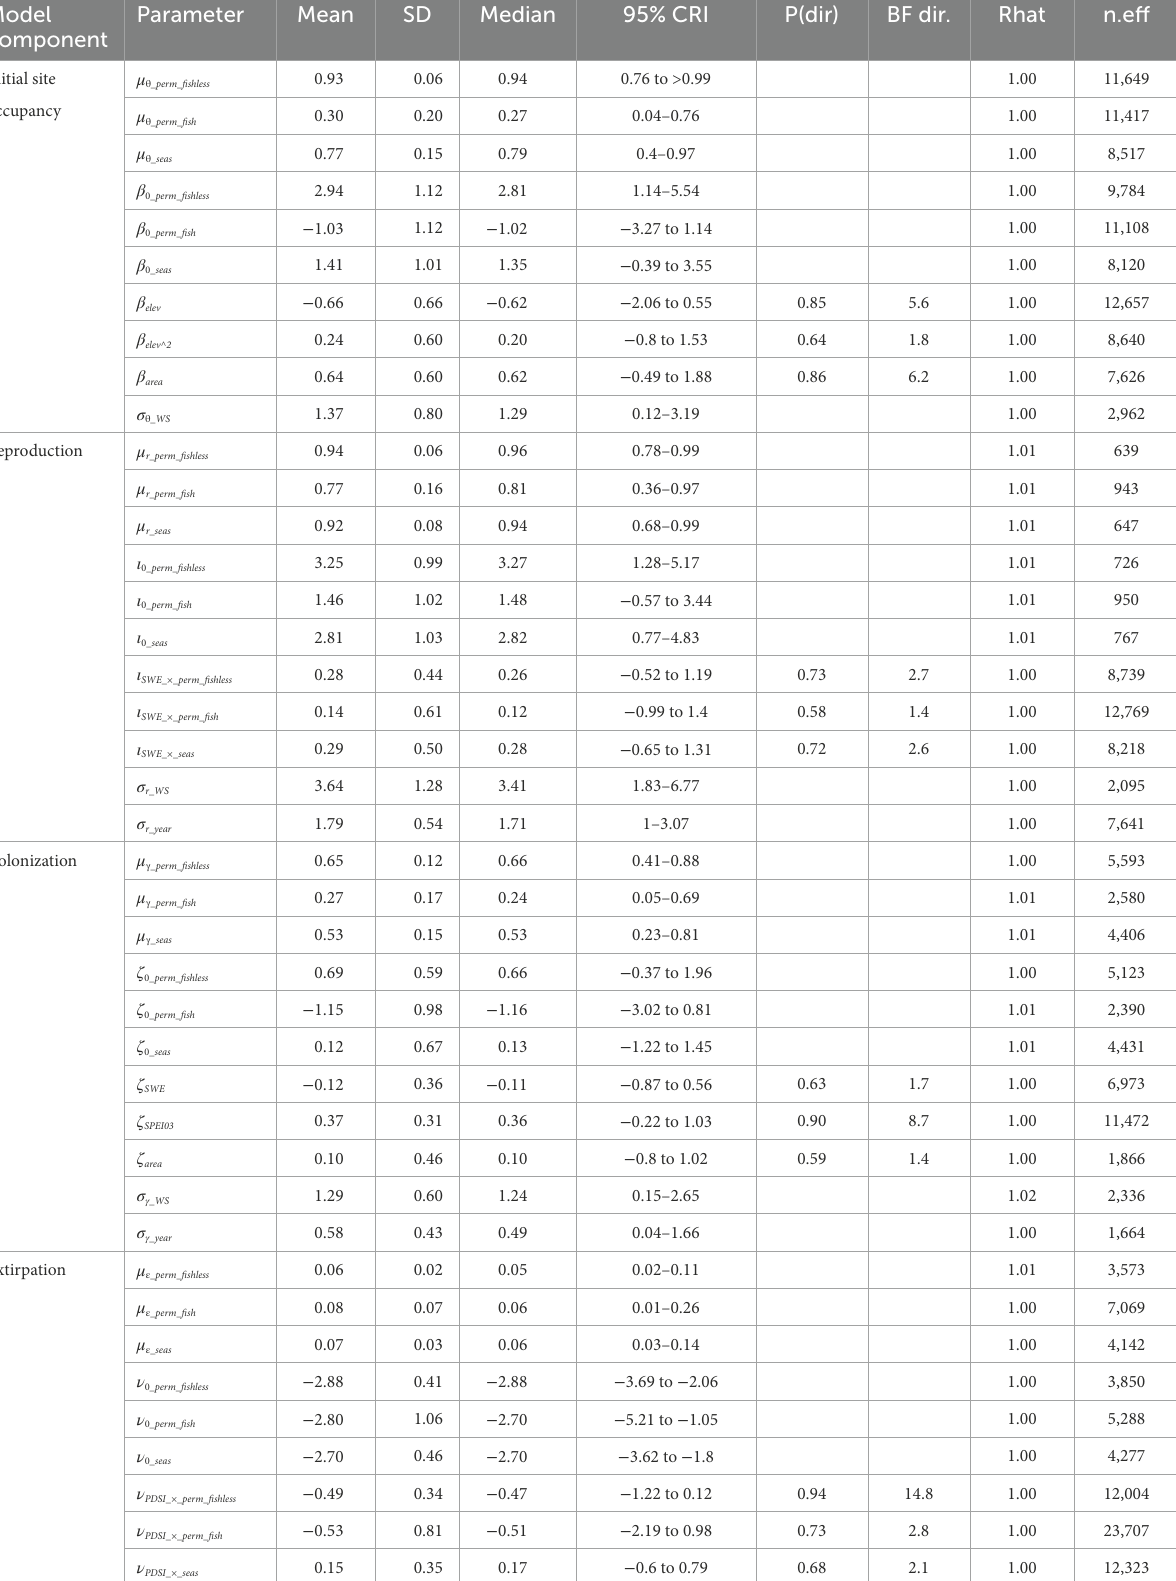
TABLE 2 Posterior summaries and Markov chain Monte Carlo (MCMC) diagnostics of parameters for the multi-state dynamic occupancy model for sierran treefrogs ( Pseudacris sierra ) in Yosemite National Park, California, United States, 2007–2021. Model Parameter Mean SD Median 95% CRI P(dir) BF dir. Rhat component